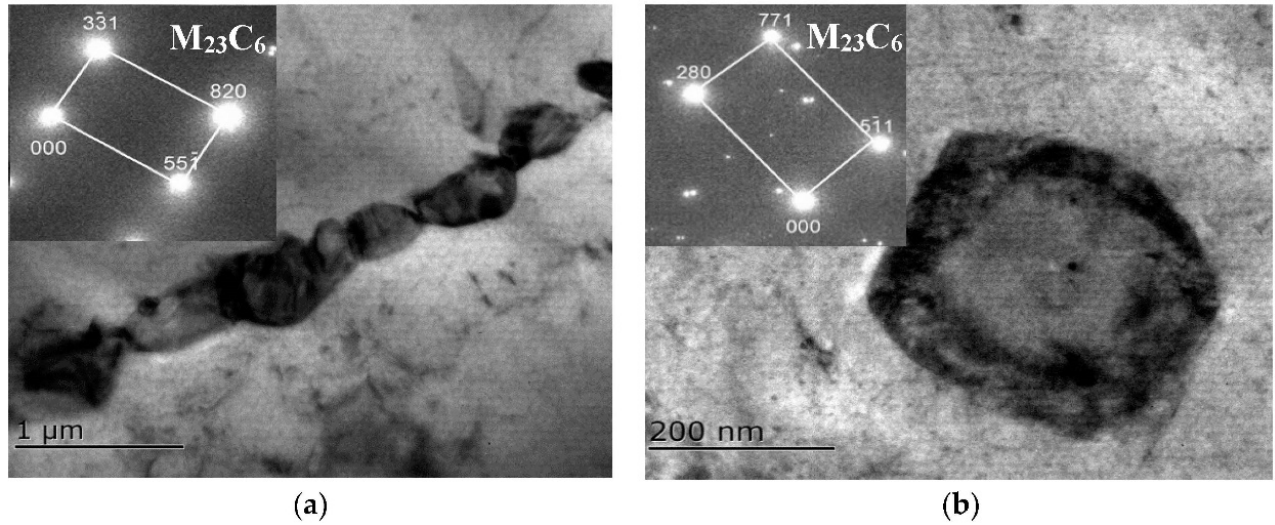
Figure 4. TEM analysis of the precipitates from the 300 h aged specimens: ( a ) intergranular precipi- tates, ( b ) intragranular precipitates.